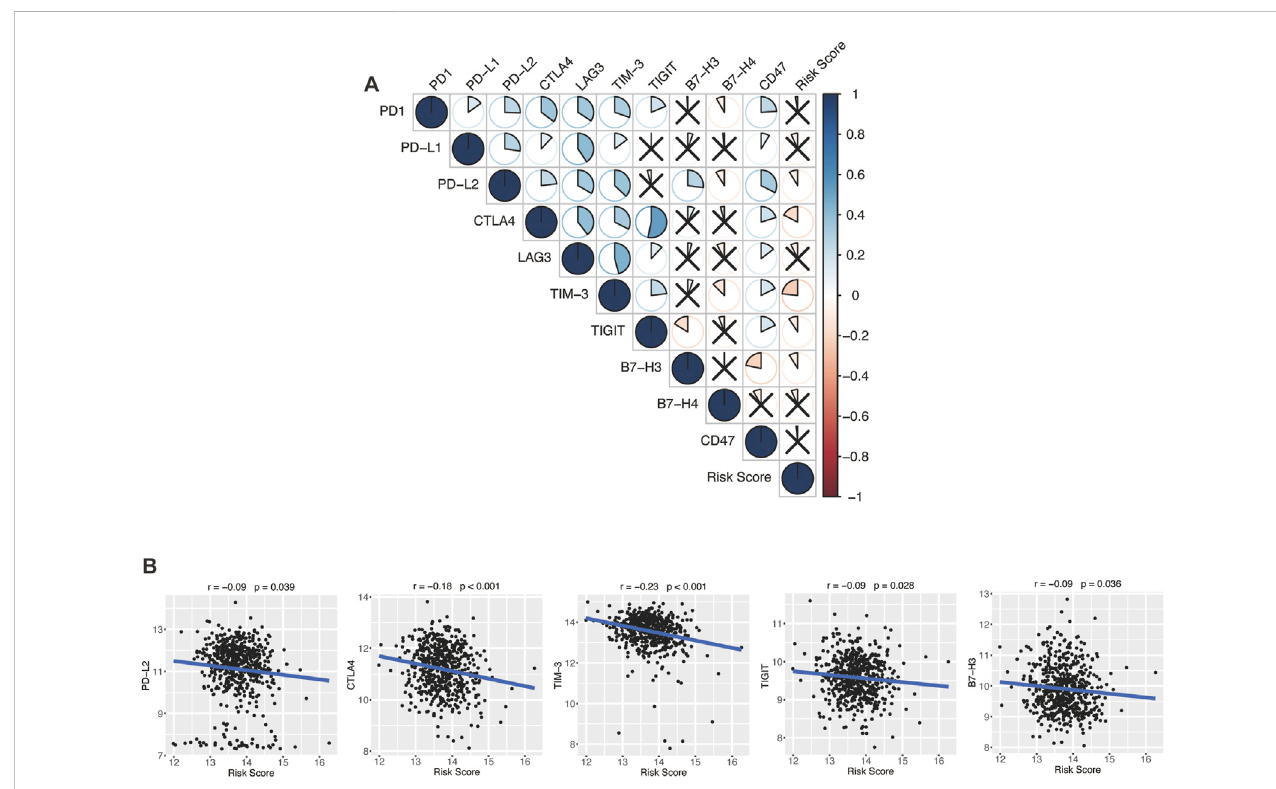
FIGURE 8 Association between the glycolytic risk model and immune checkpoint modulators. (A, B) Correlation between the risk score and immune checkpoint modulators. (B) Correlation between the risk score and expression of PD-L2 , CTLA4 , TIM-3 , TIGIT , and B7-H3